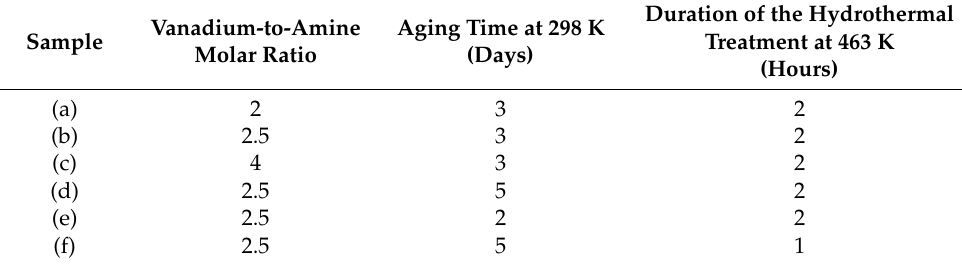
Table 2. Synthesis parameters varied to achieve hybrid vanadium oxide nanotubes.